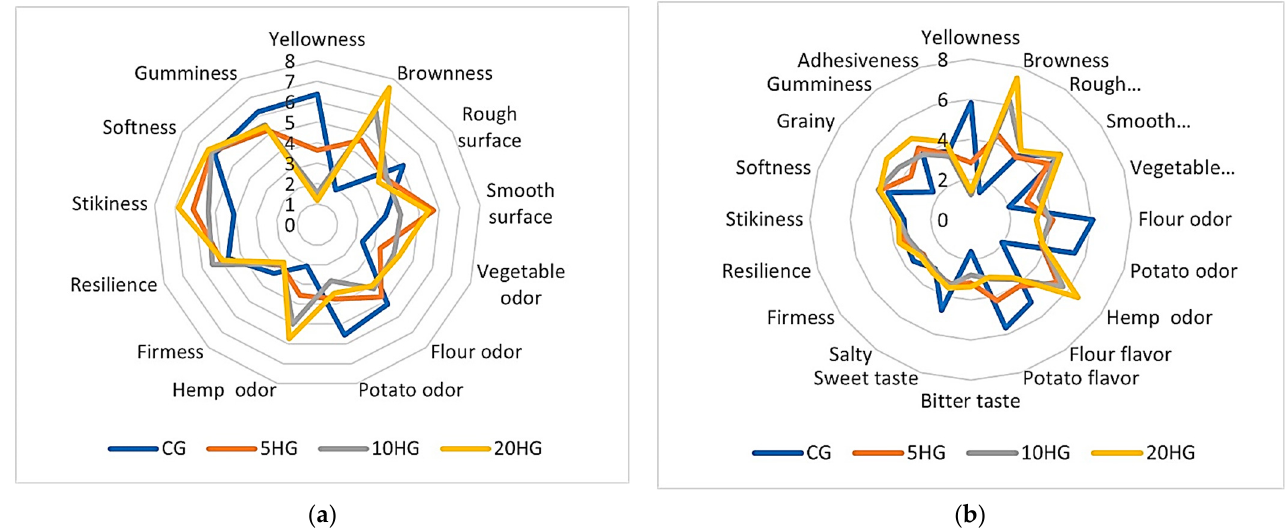
Figure 1. Spider plot representation of the QDA sensory analysis of control and hemp seed flour- enriched gnocchi samples: ( a ) raw samples; ( b ) cooked samples.